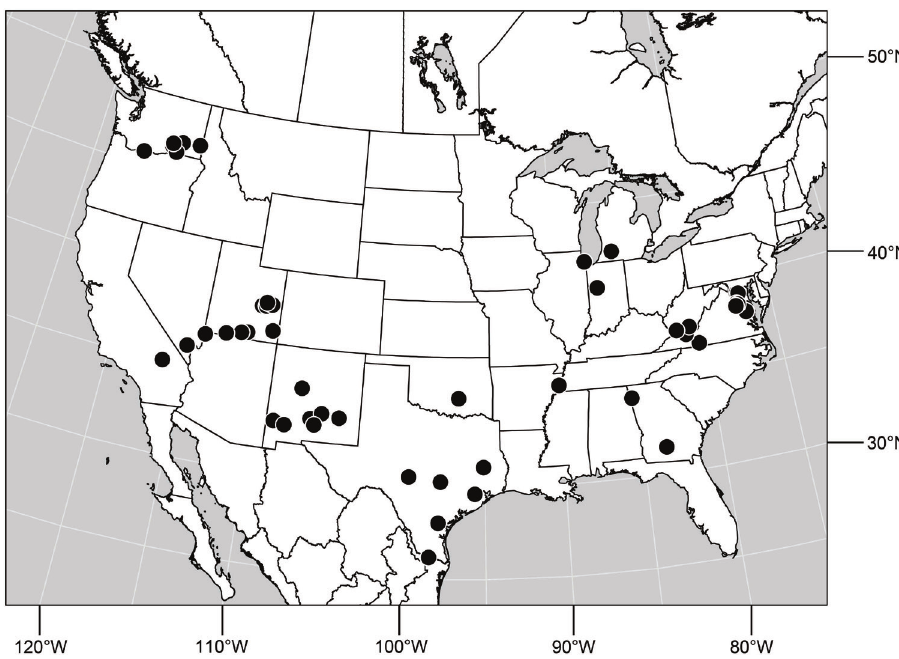
Figure 153. Distribution of Hydrochasma avanae Mathis and Zatwarnicki